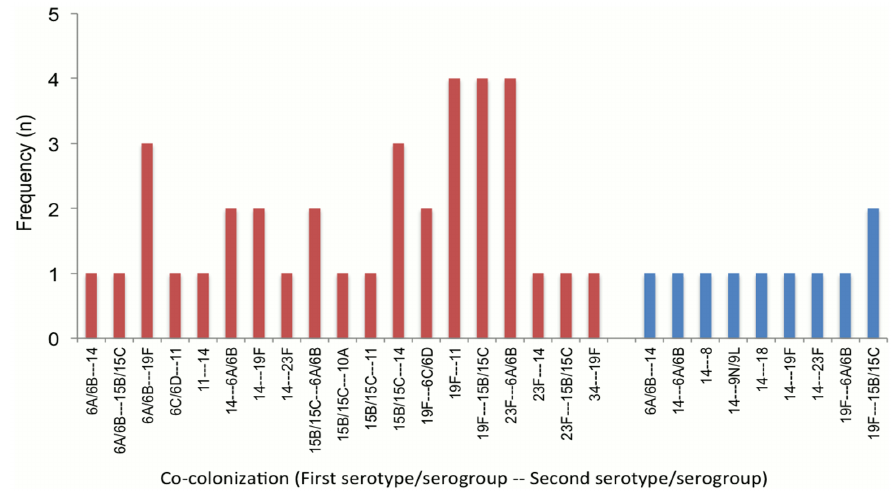
Figure 5. Distribution of co-colonization of multiple serotypes of pneumococcus. In ARI cases (red) co-colonization was detected in 36 samples out of 194 lytA positive samples (18.5%), while in healthy children (blue) it was detected in 10 samples out of 140 (7.1%) lytA positive samples. The odds ratio, adjusted for age, sex and daycare, was 2.92 (95%CI 1.27–6.71; P=0.012). The serotypes/serogroups were positioned first and second according to their bacterial load.